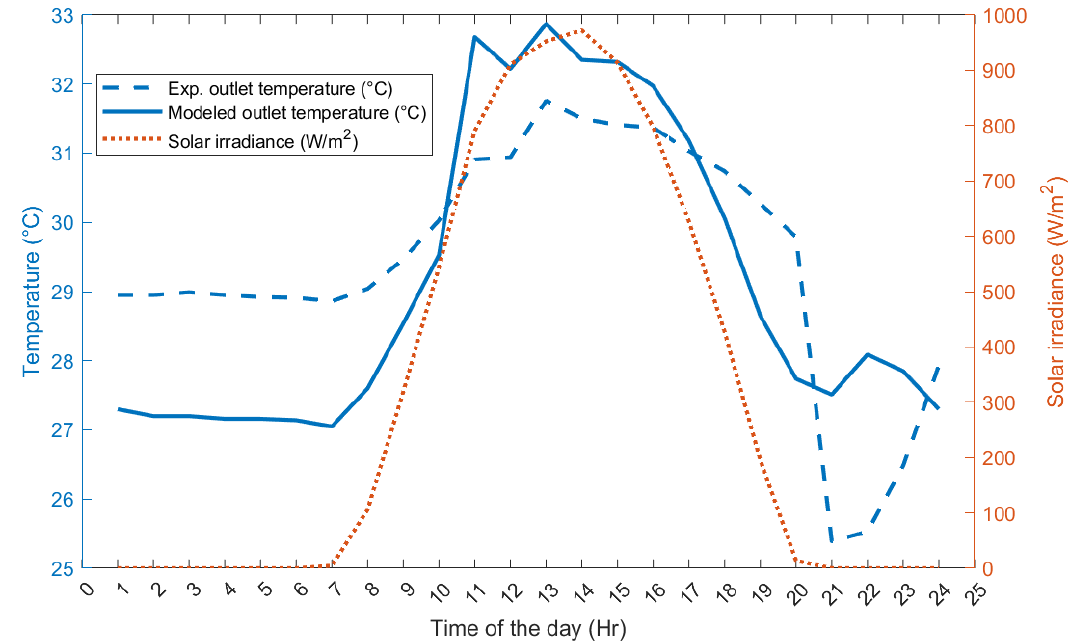
Figure 6. Comparison of experimental temperature vs. modeled outlet temperature of the GAHE located in Villas Universitas Chetumal Quintana Roo (2 m depth).